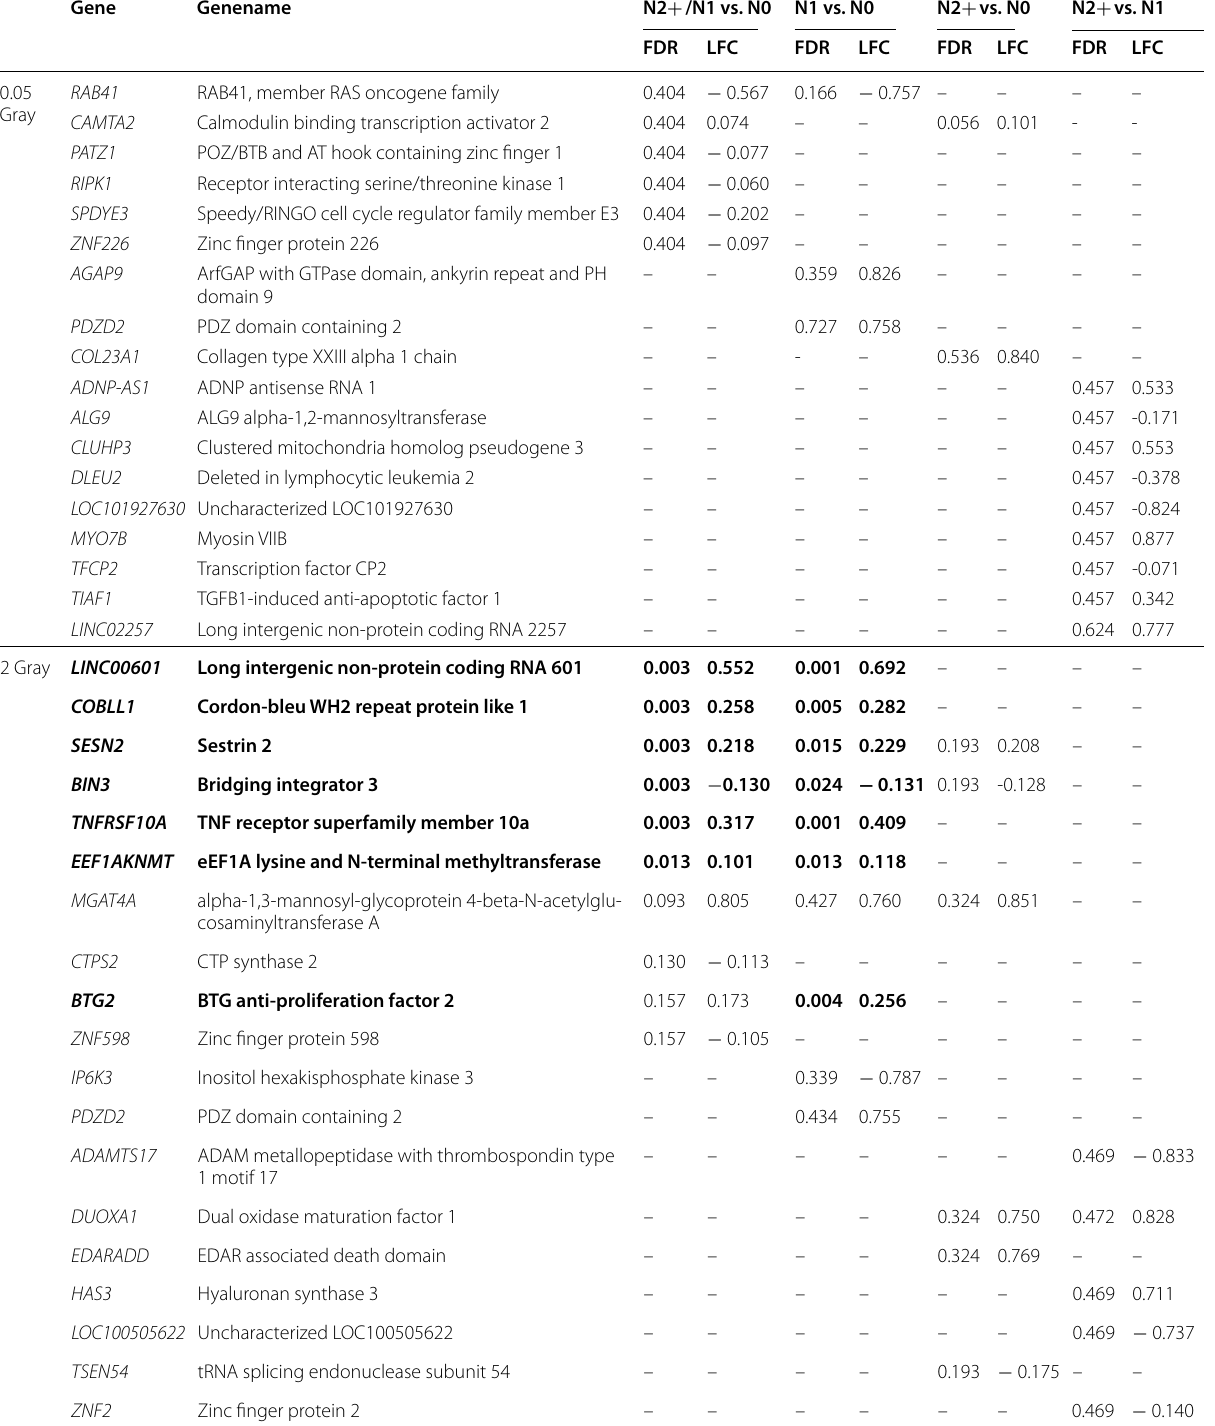
Table 2 Overview of genes for the analysis of interactions between the effect of the radiation dose and the donor group